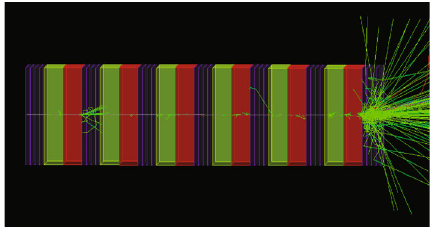
Figure 4: Geant4 simulation for a 50 TeV tau penetrating interleaved detectors made by 3 layer RPC (in blue), lead tungstate (PbWO4, in green), and copper (in red), each with 20cm ’ s length. The energetic tau fl ies like a muon and then decays into 3 charged pions and neutrinos. The gamma rays shows in green, electrons in red, and electron neutrinos in white.